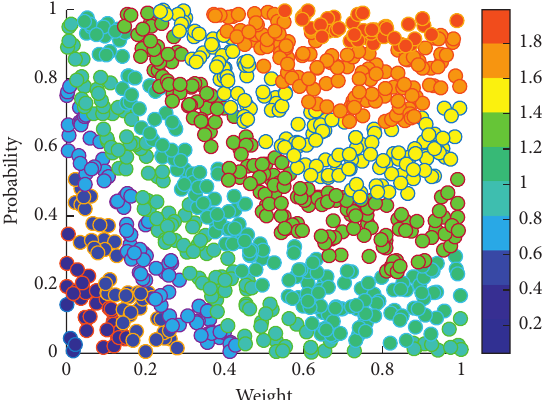
Figure 4: Distribution of node weights of the public policy and public opinion data.